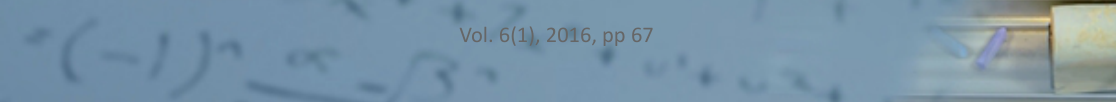
Figure 5. Example of an answer for the question from task 3 to establish whether it is true or false that the vector belongs to the